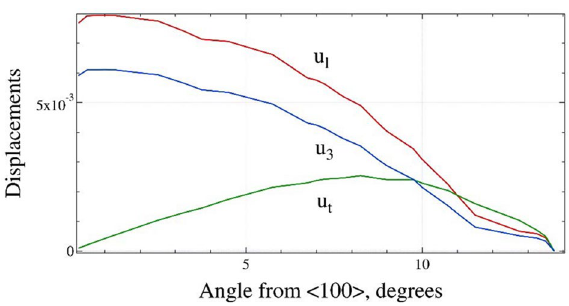
u l for the UNW mode calculated at x 3 = 0 , t ,3 (cid:31) (cid:31) (cid:31) (cid:31)